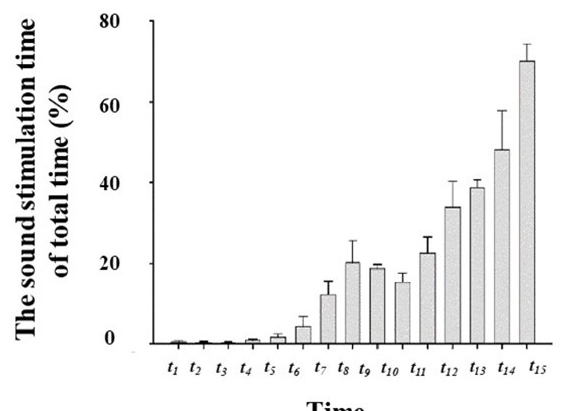
Figure 4 - Changes in rat positions relative to treadmill position by period.